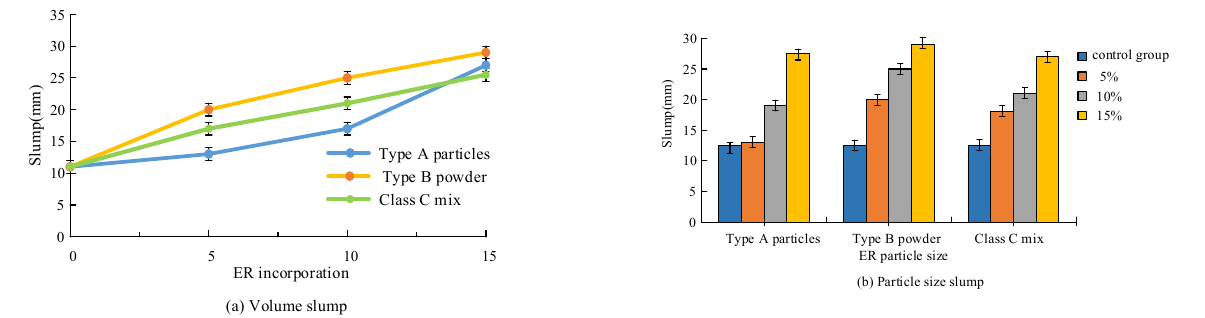
Figure 2. Comparison curve of slump with different dosage and particle size.